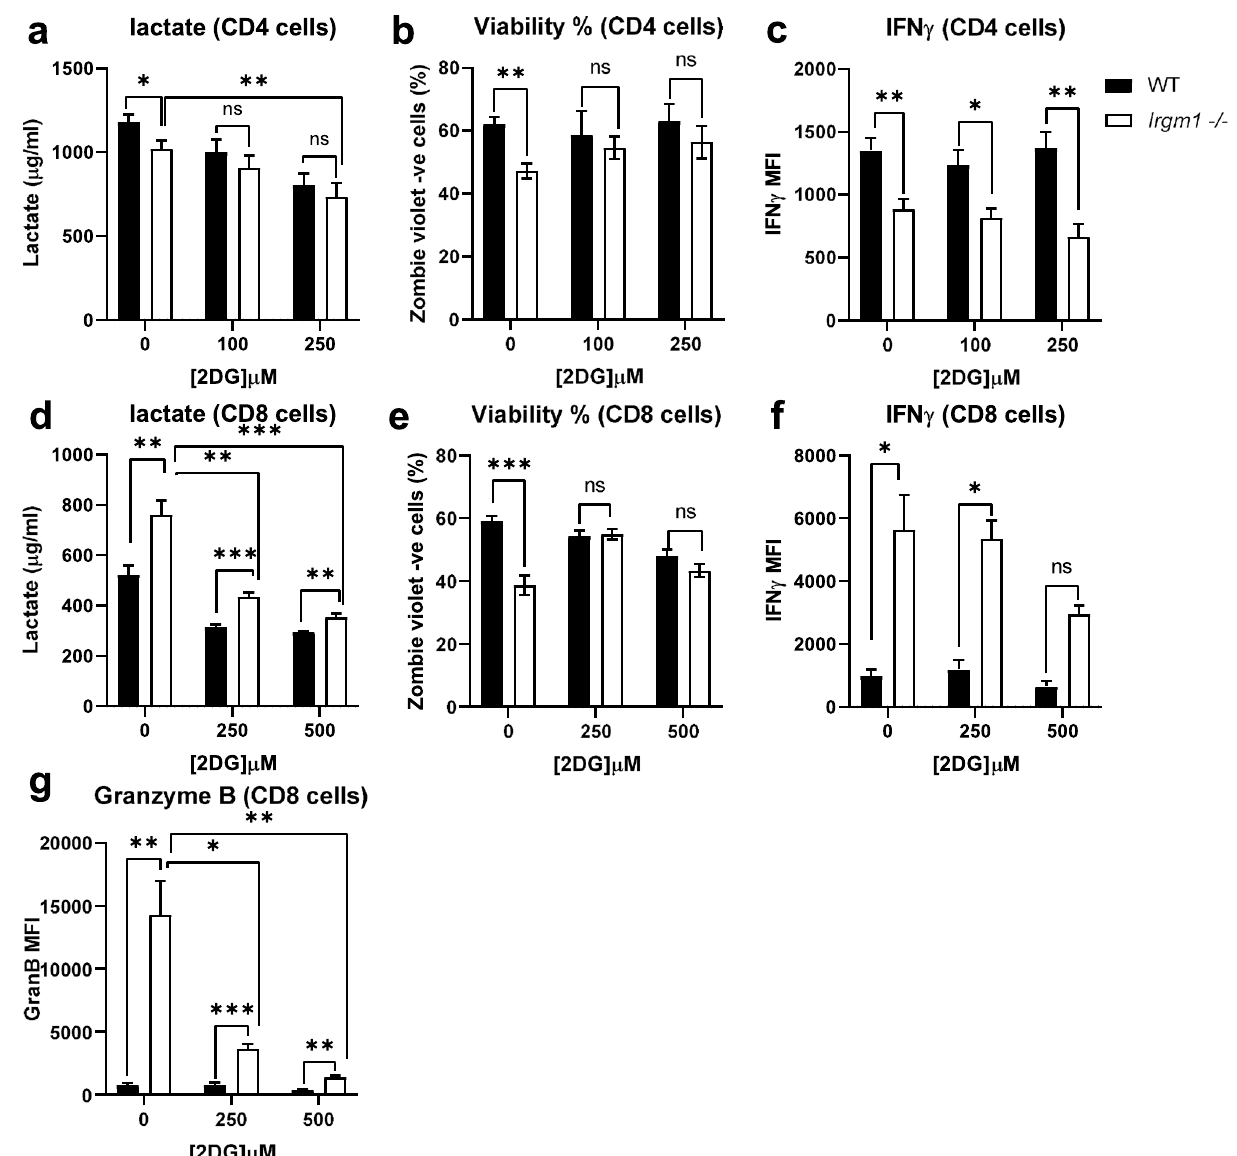
Figure 6. Inhibition of glycolysis in Irgm1 deficient T cells restores T cell viability and function. Isolated CD4 + and CD8 + T cells from WT and Irgm1 −/− mice were activated in the presence of absence of 2-deoxyglucose (2DG), after which media was collected and assayed for lactate ( a, d ) and cells were stained with Zombie violet dye to assess viability ( b, e ), then fixed, permeabilized and stained for IFNγ ( c, f ) or Granzyme B ( g ). Data pooled from two independent experiments ( n = 4–6 ); error bars represent ± SEM. Dunn’s multiple comparisons test or multiple T-test with Welch’s correction was used to compare group pairs depending on the normality of the distribution as judged by the Shapiro–Wilk test * p < 0.05, ** p < 0.01, *** p < 0.001, ns, not